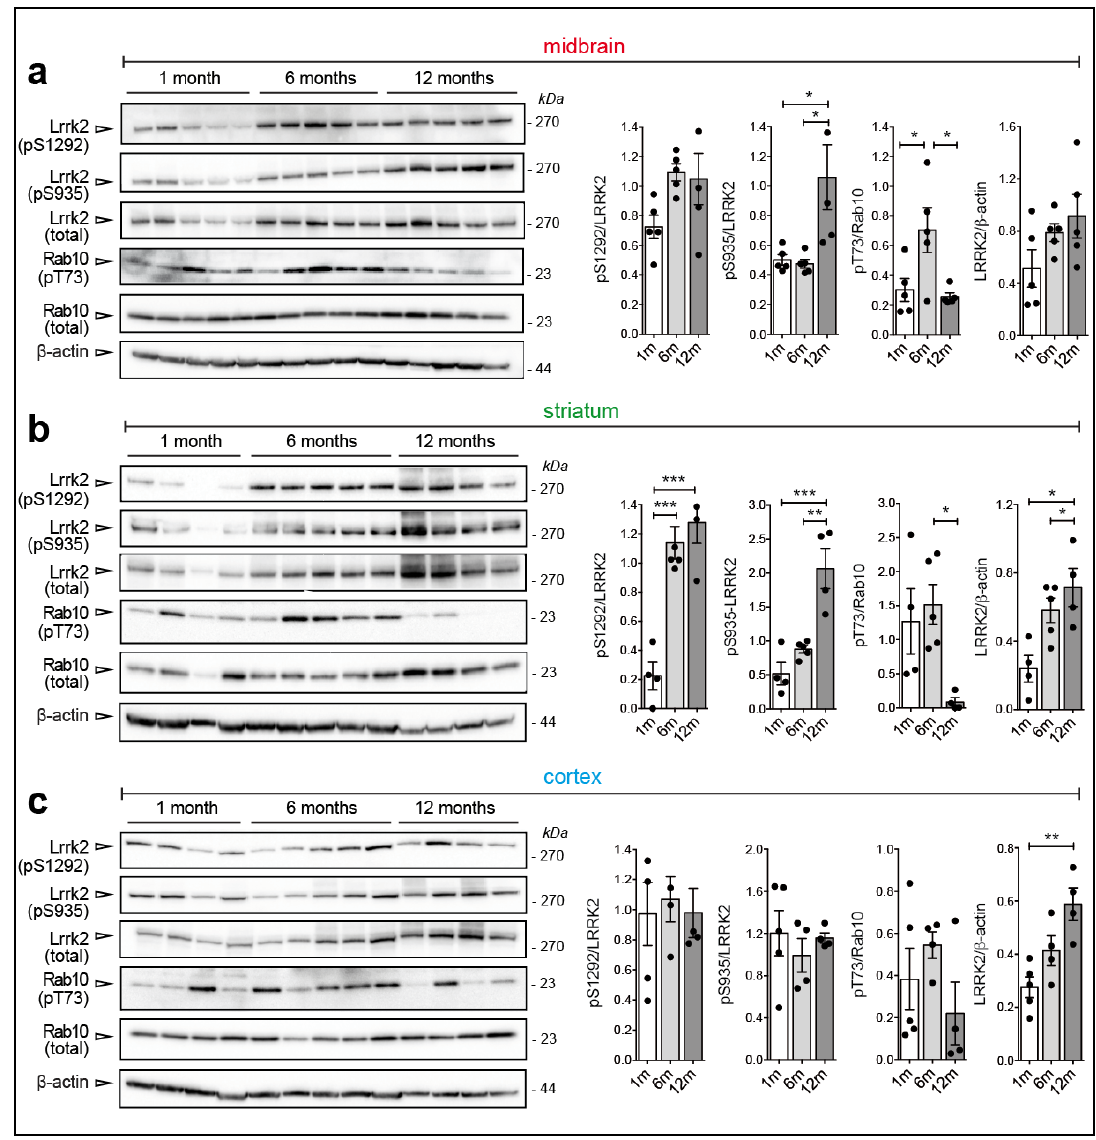
Figure 4. Age-dependent increase of Lrrk2 phosphorylation and steady state levels in BAC-Lrrk2 G2019S brains. ( a ) Representative western blots and relative quantifications of Ser935, Ser1292 phosphorylations (phospho/total Lrrk2), total Lrrk2 (total Lrrk2/ β -actin), and Thr73-Rab10 phosphorylation (phospho/total Rab10) in midbrain, ( b ) striatum, and ( c ) cortex of murine BAC-G2019S mice at different ages (1, 6, and 12-months). Each dot in the bar graph represents one animal. Data are shown as mean ± SEM; One-way ANOVA with Dunnett post-hoc test (* p < 0.05; ** p < 0.01; *** p < 0.001).